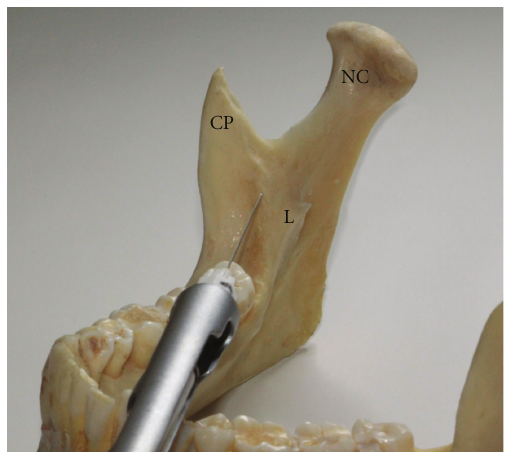
Figure 4: Photograph of the mandible showing the positioning of the needle tip when administering the anterior IANB. Note that the location of the needle tip is a considerable distance from where the IAN would be expected. This technique relies heavily on the ability of local anaesthetic to di ff use throughout the pterygomandibular space (NC: neck of Condyle, CP: coronoid process, L: lingula).